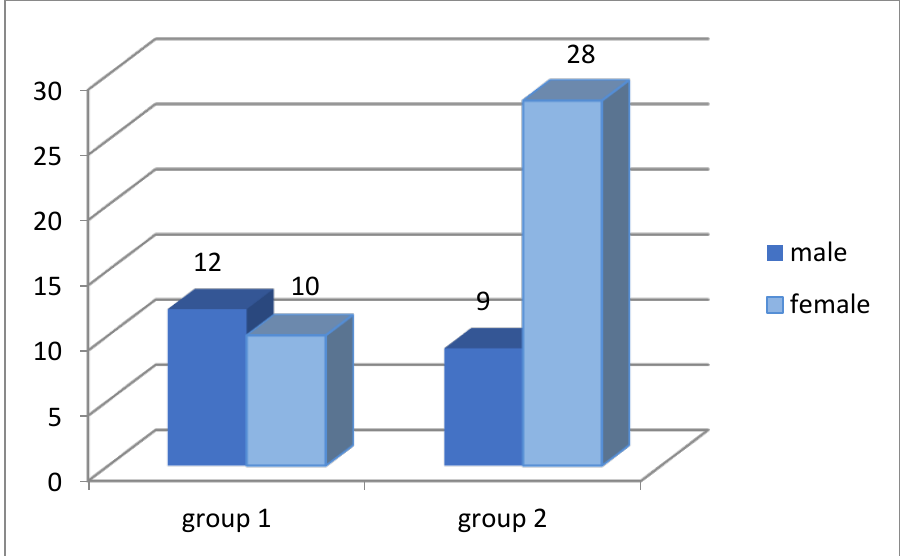
Figure 4. Diagram of gender distribution of patients with ISSf: group 1 with effective medical therapy, group 2 with unsuccessful medical therapy. Table 2. Complaints of patients with ISS.